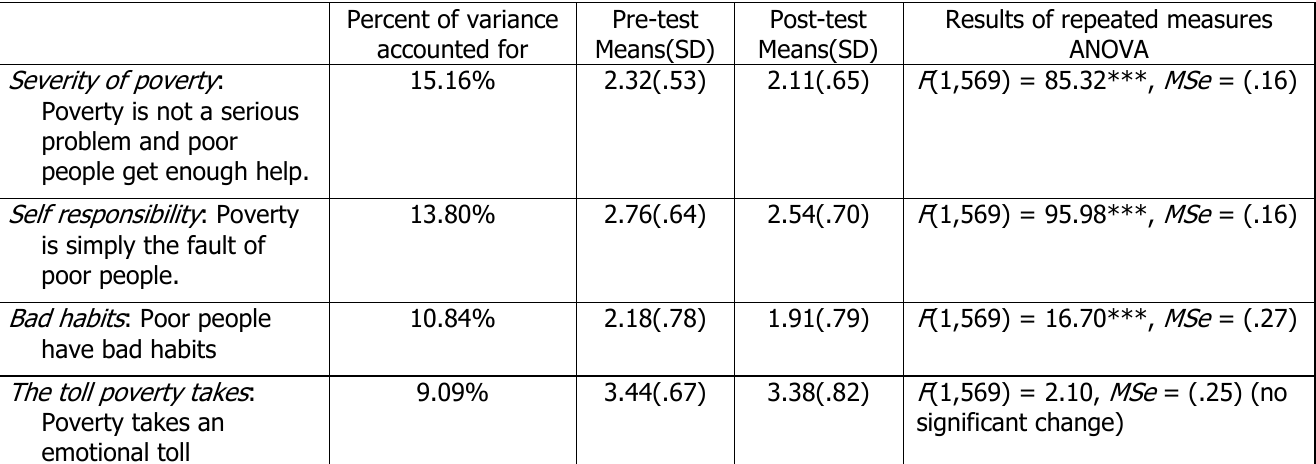
Descriptive statistics and results of within-groups comparisons Percent of variance accounted